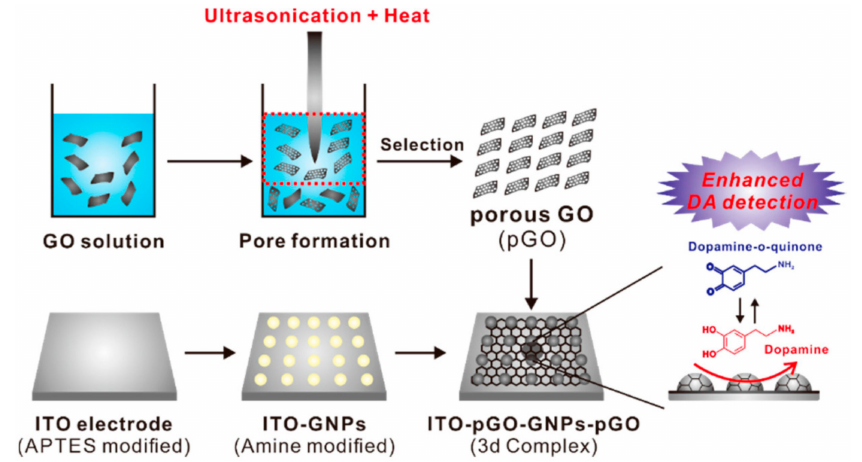
Figure 5. The modification process of 3D porous graphene oxide/gold nanoparticle composites. Reprinted with permission from